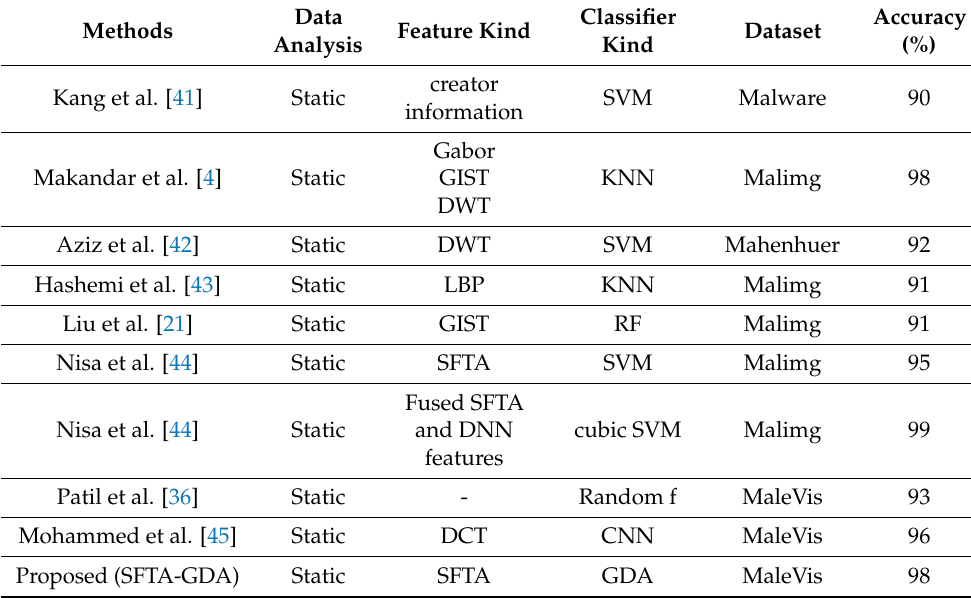
Table 5. Comparative Findings of current MD/MC